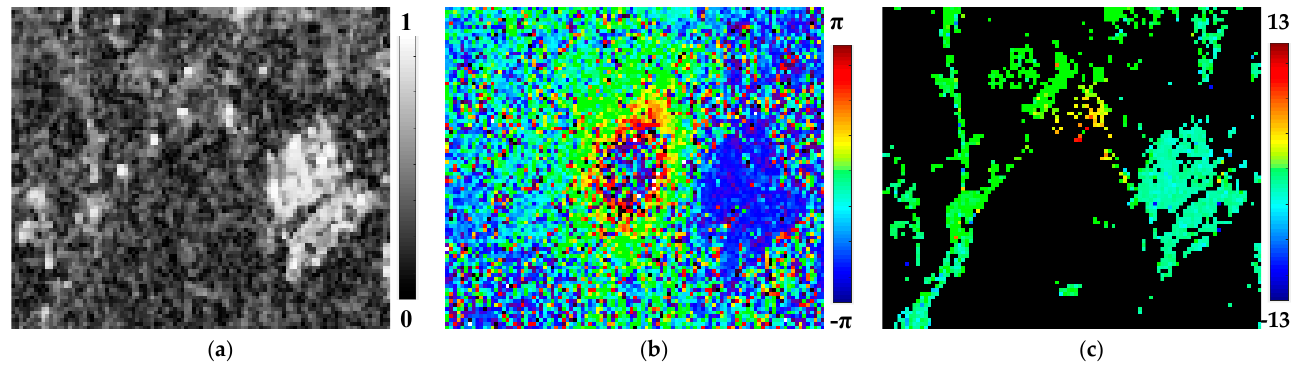
Figure 10. Mean amplitude ( a ), co-seismic wrapped ( b ) and unwrapped ( c ) interferograms of the Rudna mine area, in the vicinity of the WYZY GNSS station and seismometer. Master